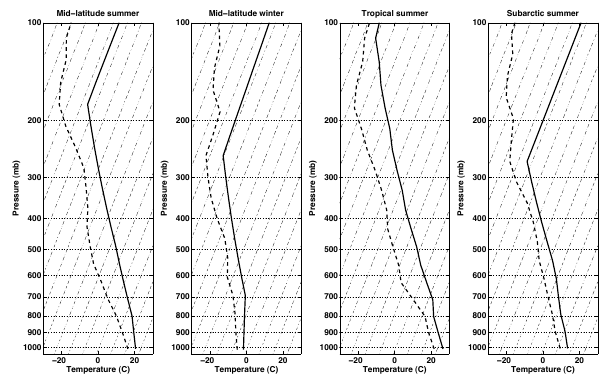
Fig. 2. The McClatchey climatological soundings (in skew-T plots) Figure 2. The McClatchey climatological soundings (in skew-T plots) used in this study mid-5 used in this study (from left to right): mid-latitude summer, mid- latitude summer (left) and winter (right). In these plots, temperature is in full line, dew point 6 latitude winter, tropical summer, and subarctic summer. In these plots, temperature is in full line, dew point temperature is in dashed. temperature is in dashed. 7